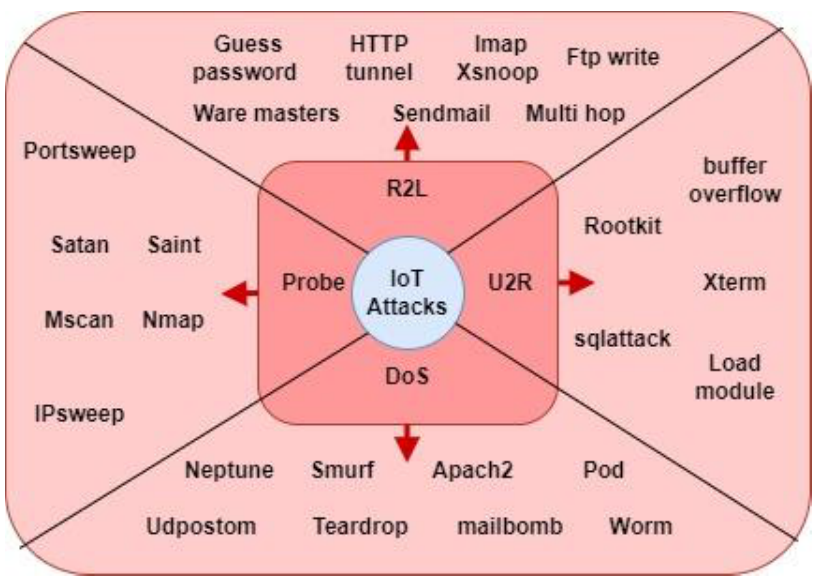
Figure 4. NSL-KDD dataset description.